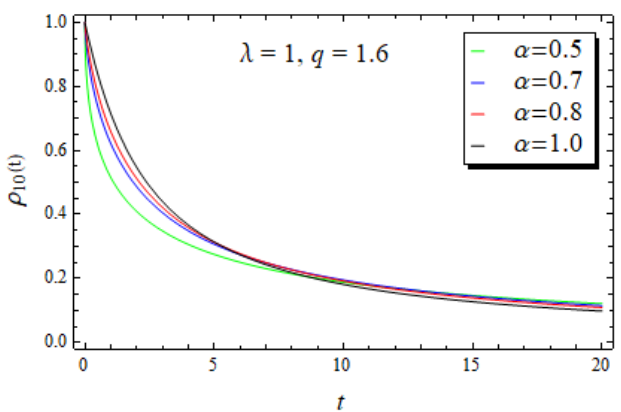
Figure 2. The variation of the approximate solution versus the conformable derivative order α .